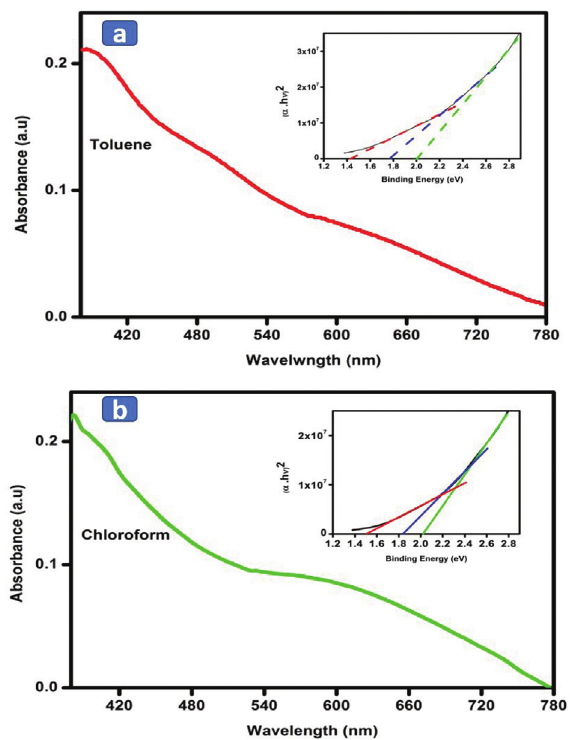
Figure 4: UV visible spectra of IBS films fabricated from (a) toluene (b) chloroform, insets are respective Tauc’s plot indicating band gaps of individual components.